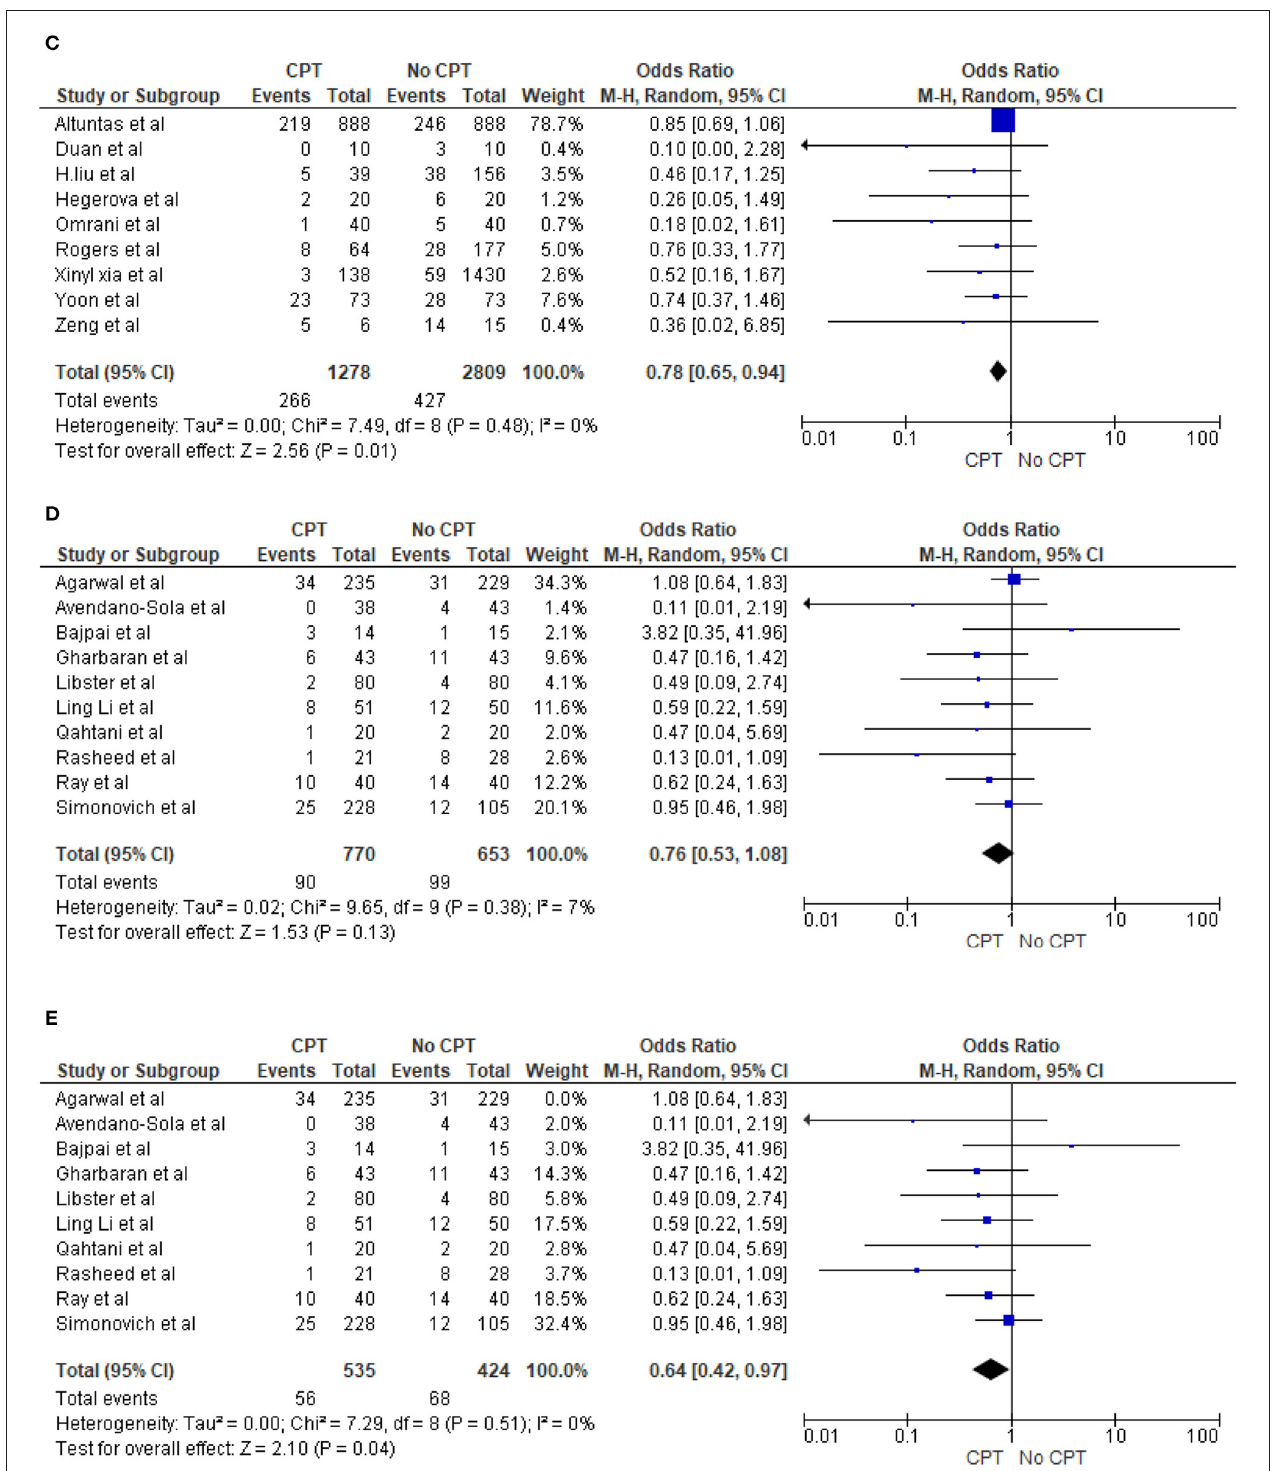
FIGURE 2 | (A) Overall comparison of mortality rate in patients on CPT vs. non-CPT treatment. (B) Subgroup analysis of mortality rate in patients on CPT vs. non-CPT treatment (trial/prospective studies). (C) Subgroup analysis of mortality rate in patients on CPT vs. non-CPT treatment (observational). (D) Sensitivity analysis for mortality rate in patients on CPT vs. non-CPT treatment (trial/prospective studies) true randomized controlled trial (removed pseudorandomized or trial with matched cohort). (E) Sensitivity analysis for mortality rate in patients on CPT vs. non-CPT treatment (trial/prospective studies) true randomized controlled trial [removed Agarwal et al.